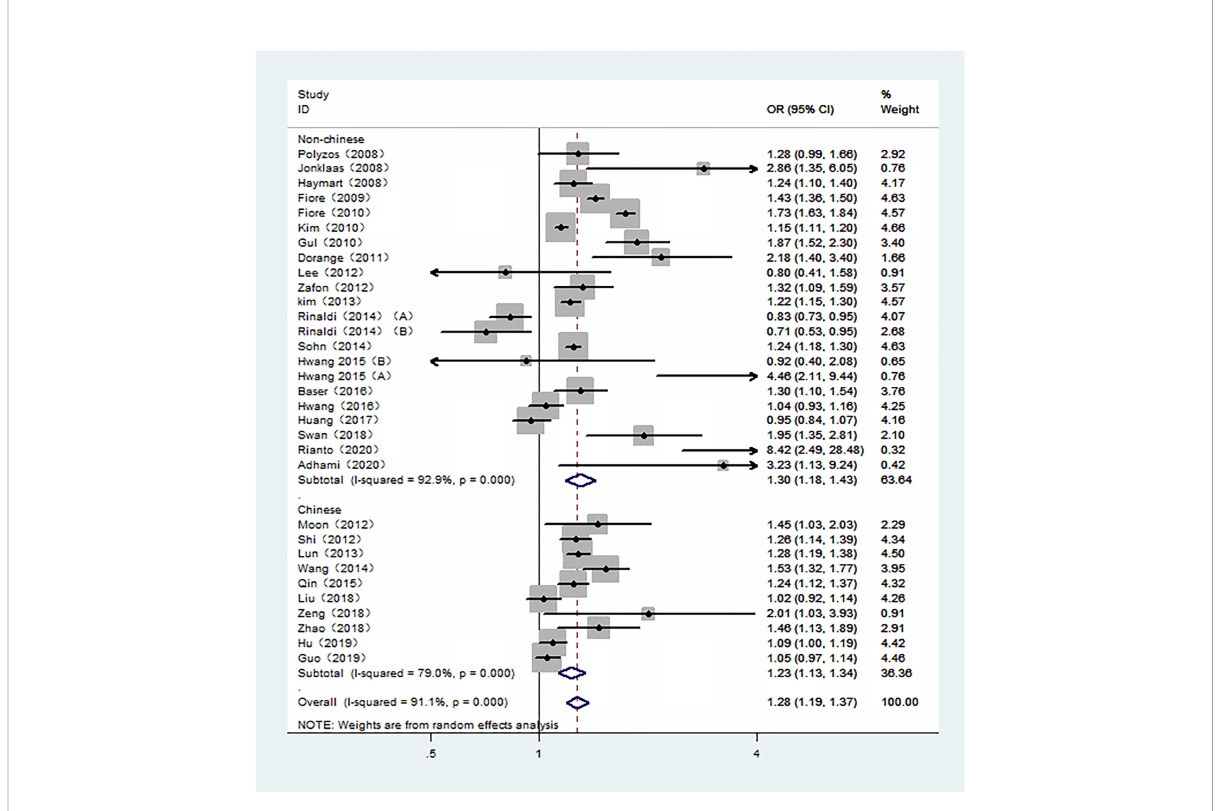
FIGURE 2 Forest plot of the risk of TC associated with TSH. Hollow diamonds represent pooled OR. Error bars indicate 95% CI.